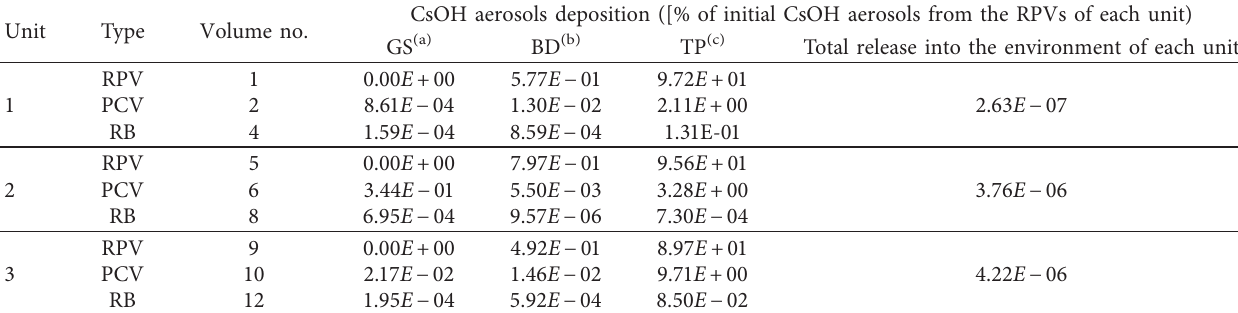
(a) Gravitational settling on floor. (b) Brownian diffusion on wall. (c) Thermophoresis on wall.